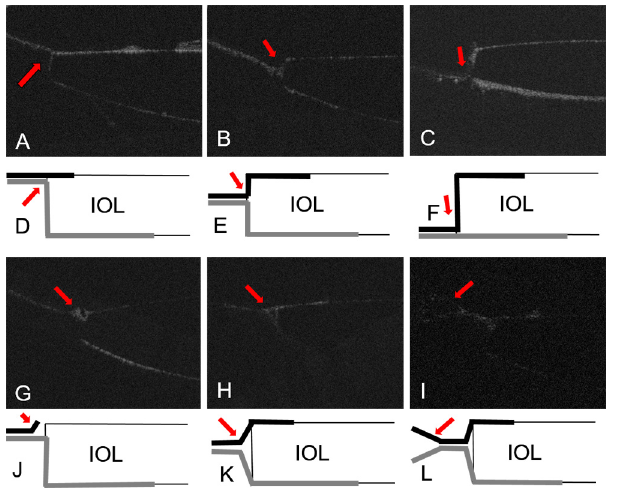
Fig 3. UL-OCT images (A-C & G-I) and corresponding schematic (D-F & J-L) of capsular bend types. Red arrows demonstrate the characteristics of different capsular bend types. In schematic images, black and gray lines represent anterior and posterior capsules, respectively. (A and D) Anterior adhesion type: the posterior and anterior capsule form a stable adhesion at the anterior surface of the IOL optic edge. (B and E) Middle adhesion type: the posterior and anterior capsule wrapped around the IOL and met at the middle of the IOL edge. (C and F) Posterior adhesion type: the anterior and posterior capsule form a stable adhesion at the posterior surface of the IOL. (G and J) Detachment type: the anterior capsule detached from the IOL optic edge. (H and K) Funnel adhesion type: the posterior and anterior capsules adhered to each other, but a space between the capsule and IOL remained and showed the appearance of a funnel. (I and L) Furcate adhesion capsule type: the inner sides of the posterior and anterior capsules adhered, whereas the peripheral side was separated.